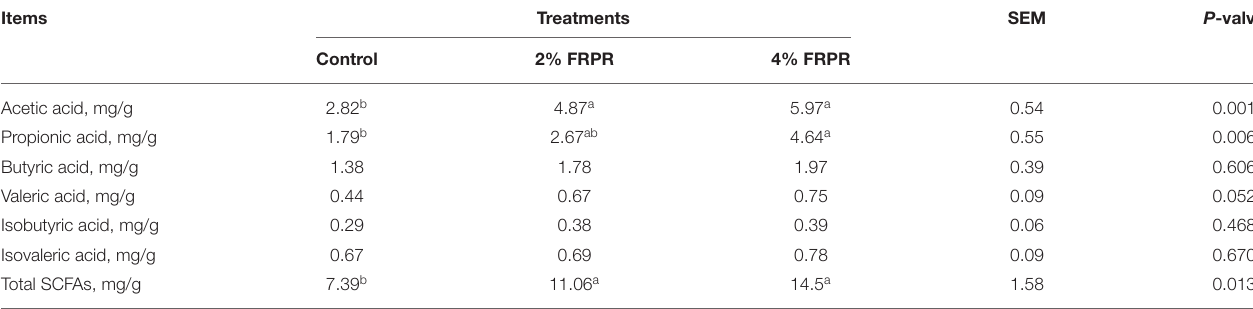
TABLE 4 | Effects of dietary supplementation with FRPR on short-chain fatty acid (SCFA) contents in feces of the sows 1 . Items